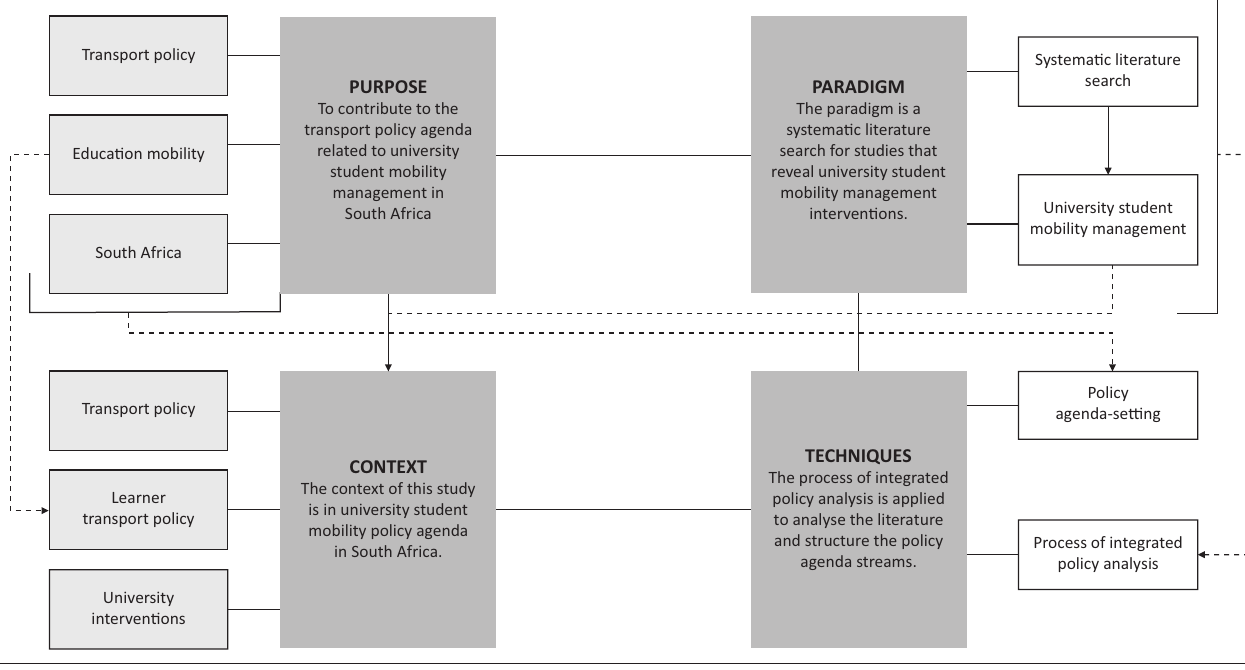
FIGURE 2: Research